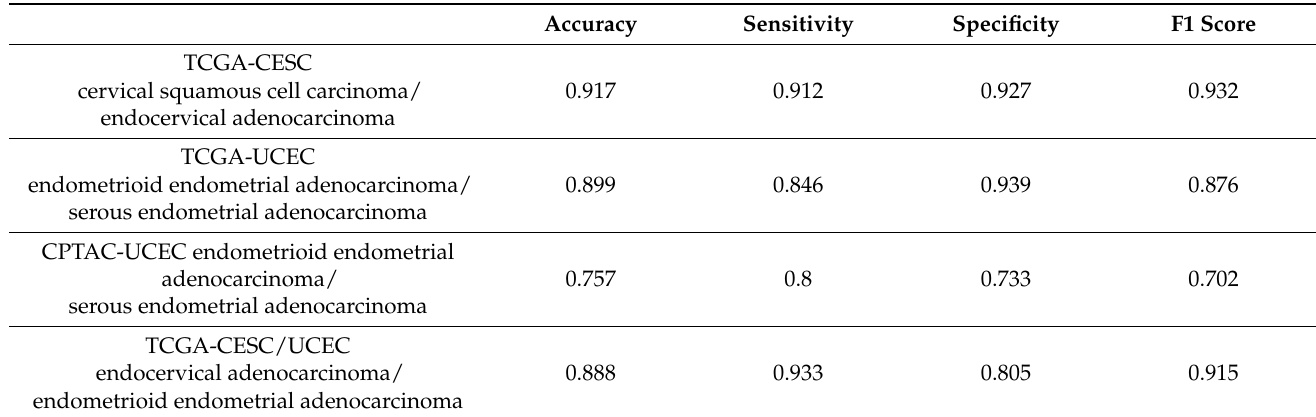
Table 1. Accuracy, sensitivity, specificity, and F1 score of the classification results. The measures were obtained with cutoff values yielding maximal Youden index (sensitivity + specificity − 1).